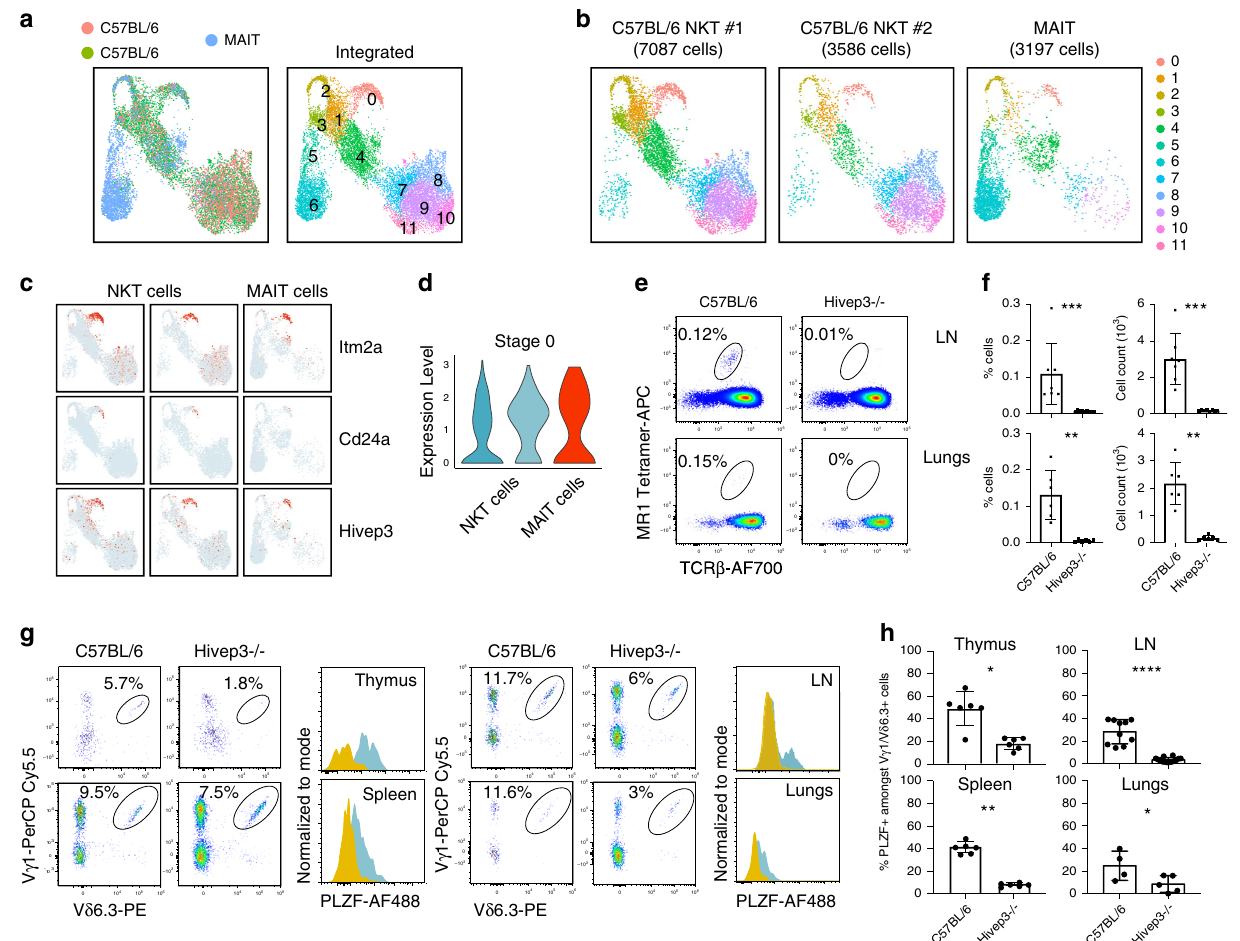
Fig. 8 Hivep3 de fi ciency universally impacts PLZF-expressing innate-like T lymphocytes. a Left , UMAP displaying two iNKT and one MAIT scRNA-seq sample colored by sample of origin after MNN batch-correction. Right , UMAP colored by inferred cluster identity for the integrated dataset. b Individual UMAP plots for each biological sample in the dataset, with the sample and number of cells passing quality control and fi ltering indicated above each plot. c Expression of selected genes in the iNKT and MAIT scRNA-seq samples. Each dot represents one cell and gene expression is plotted along a colorimetric gradient, with red corresponding to high expression. d Violin plots displaying aggregate expression levels of Hivep3 in stage 0 cells for each sample. e MAIT cells in C57BL/6 and Hivep3 − / − mice were identi fi ed in the indicated tissues by staining with the MR1 tetramer and an antibody targeting TCR β . f Quanti fi ed MAIT cell proportions and numbers in C57BL/6 and Hivep3 − / − mice in each of the indicated tissues. Data are from two independent experiments with a total of 5-7 mice per group. LN: p = 0.0002 and p = 0.0022, Lungs: p = 0.0022 and p = 0.0022 for percentages and absolute numbers, respectively. g V γ 1 + V δ 6.3 + γδ T cells in C57BL/6 and Hivep3 − / − mice were identi fi ed in the indicated tissues by staining with antibodies targeting V γ 1 and V δ 6.3. PLZF expression in these cells from each tissue is plotted as an overlaid histogram with C57BL/6 cells colored in blue and Hivep3 − / − cells colored in yellow. h Quanti fi ed PLZF + V γ 1 + V δ 6.3 + cell proportions in C57BL/6 and Hivep3 − / − mice in each of the indicated tissues. Thymus p = 0.0108, LN p = 0.0002, Spleen p = 0.0022, Lungs p = 0.0022. Data are from 2 – 3 independent experiments with a total of 6-7 total mice per group. All the data are mean ± SD with dots representing individual values. Source data are provided as a source data fi